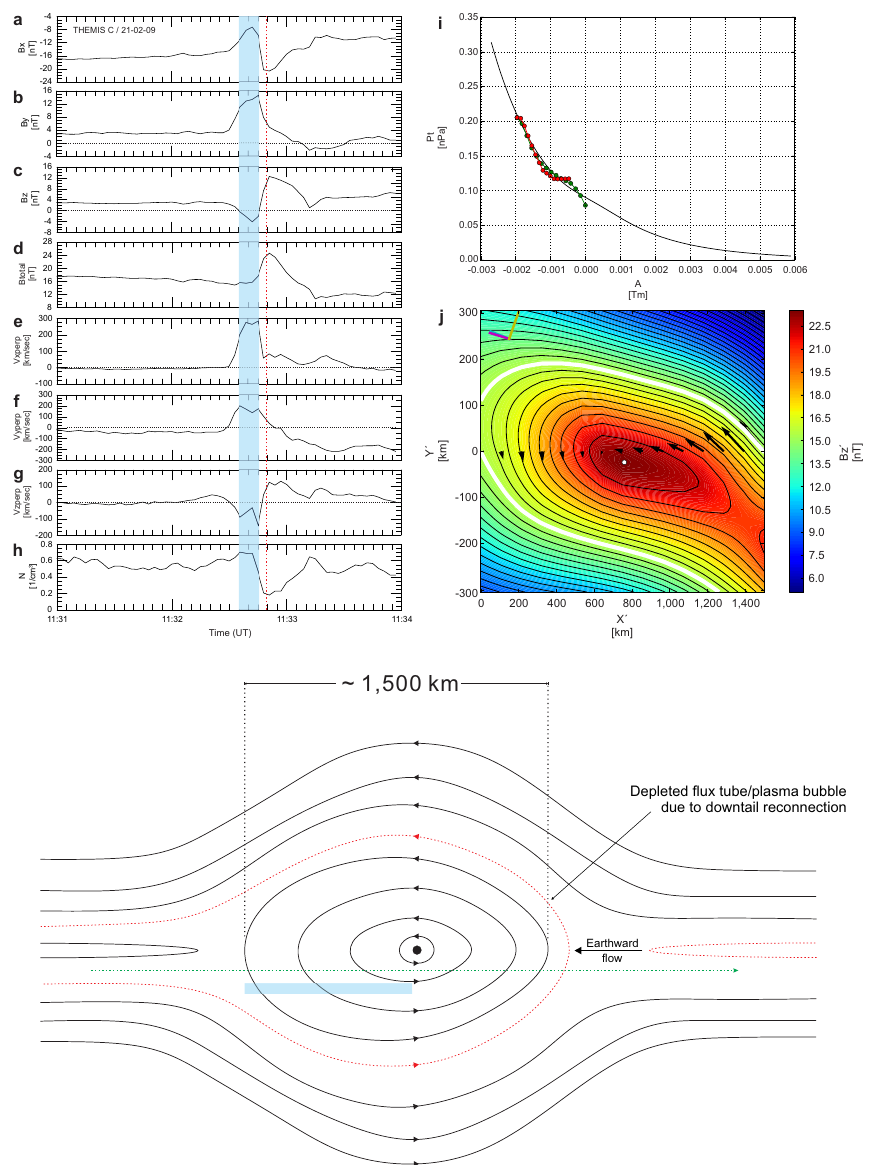
Figure 1. Downtail flux rope convected earthward observed by THEMIS C on 21 February 2009. Panels (a) – (h) show the three magnetic field components, magnetic field intensity, the three convective plasma velocity components, and plasma density. Panels (i) and (j) result from the GS reconstruction analysis. Panel (i) shows the two branches of the curve of the transverse magnetic pressure versus vector potential for the optimal direction of the invariant axis of the flux rope. The two branches correspond to the spacecraft movement inward and outward of the flux rope and the black curve is the analytical fit of Pt(A) . Panel (j) shows the GS reconstructed magnetic field map of the flux rope cross section. X (cid:48) , Y (cid:48) and Z (cid:48) axes constitute the coordinate system of GS reconstruction, which is projected onto GSM coordinates as follows: X (cid:48) = [− 0 . 655 , − 0 . 680 , 0 . 329 ] , Y (cid:48) = [ 0 . 260 , 0 . 205 , 0 . 943 ] , Z (cid:48) = [− 0 . 709 , 0 . 704 , 0 . 042 ] . The white thick curve corresponds to the time interval used for GS reconstruction. The schematic illustration at the bottom of the figure is a 2-D cut in a plane containing the Earth and the apex of the flux rope, where the invariant axis is approximately perpendicular to this plane (and not necessarily where the spacecraft crossed the flux rope). In this regard, the earthward flow label denotes the velocity of the HT frame estimated in the apex of the flux rope.